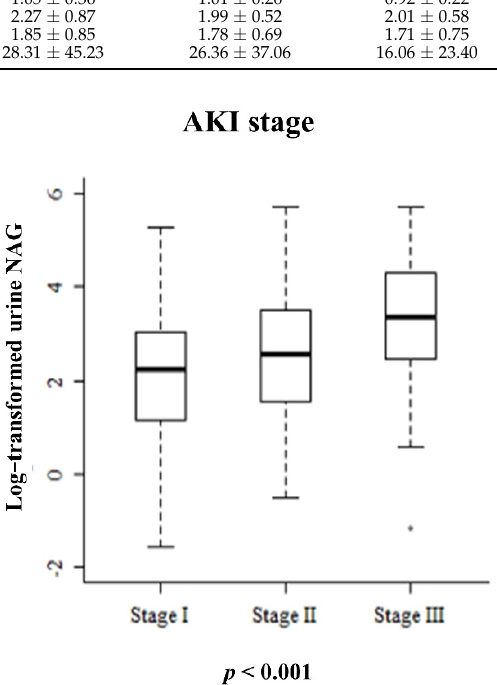
Figure 1. Boxplot comparing the mean urine NAG according to AKI